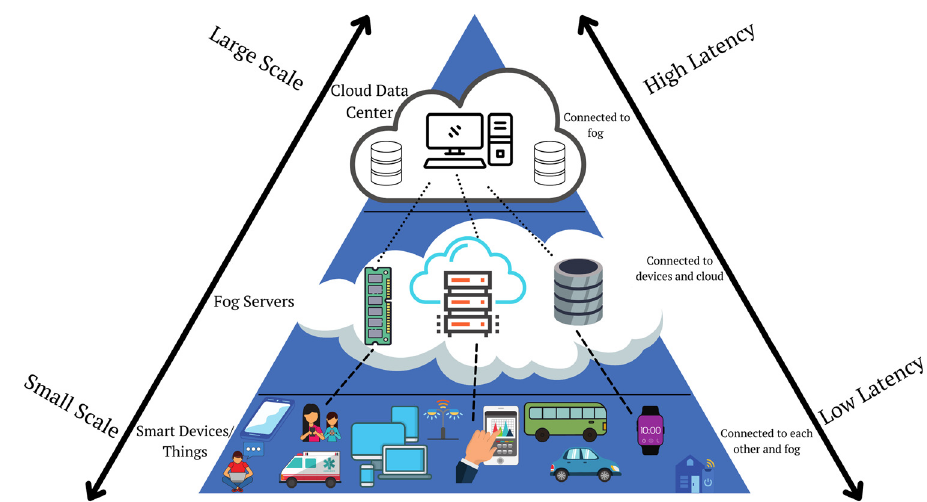
Figure 2. Architecture of fog computing.